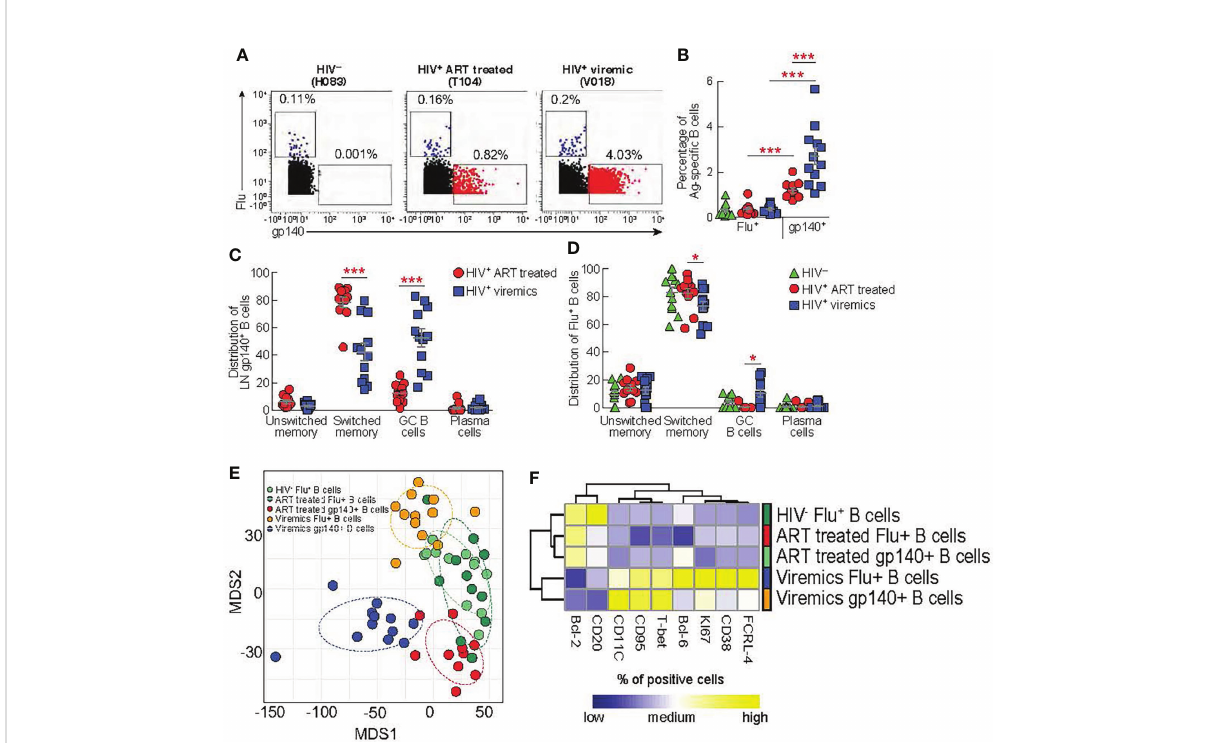
FIGURE 4 Comparison between lymph node gp140 and in fl uenza speci fi c B cells. LNMCs from HIV uninfected (N = 12) infected HIV-infected ART treated individuals (N = 11) and HIV infected viremic individuals (N = 12) were stained with a panel of 37 markers (Table S1B). (A) Representative mass cytometry pro fi les of LN CD19 + IgG + B cell populations binding to gp140 or Flu (H1-CA09) probes in representative HIV - , HIV-infected ART treated individuals and viremic subjects. (B) Cumulative data on the frequencies of Flu and gp140-speci fi c B cells in LNs of HIV - (green), HIV- infected ART treated individuals (red) and viremic (blue) individuals. Cumulative data on the distribution of (C) gp140-speci fi c B cells and (D) Flu- speci fi c B cells within the unswitched memory (IgD + CD38 - ), switched memory (IgD - CD38 - ), GC (IgD - CD38 + ) and plasma cells (IgD - CD38 hi ) B cell populations. (E) Multi-dimentional scaling (MDS) of Flu + B cells, gp140 + B cells from HIV - , ART-treated and viremic HIV-infected subjects. (F) Heat map of scaled mean marker expression (% of positive cell gated) in gp140-speci fi c B cells from HIV-infected ART treated individuals and viremic individuals, and Flu-speci fi c from HIV uninfected HIV-infected ART treated individuals and viremic individuals. All markers shown are signi fi cantly different between groups (FDR < 0.05). Differences were calculated using linear regressions. In (B ‐ D) P values were obtained